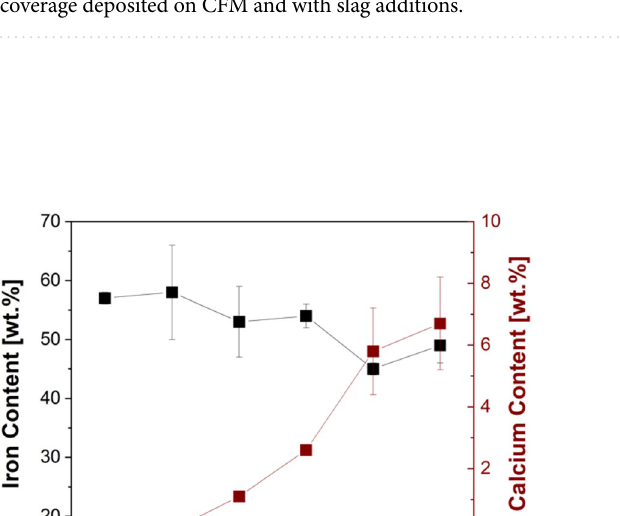
Figure 5. Worn surface characteristics ( a ) CFM; ( b ) CFM + 38FS; ( c ) Estimation of secondary plateau area coverage deposited on CFM and with slag additions.